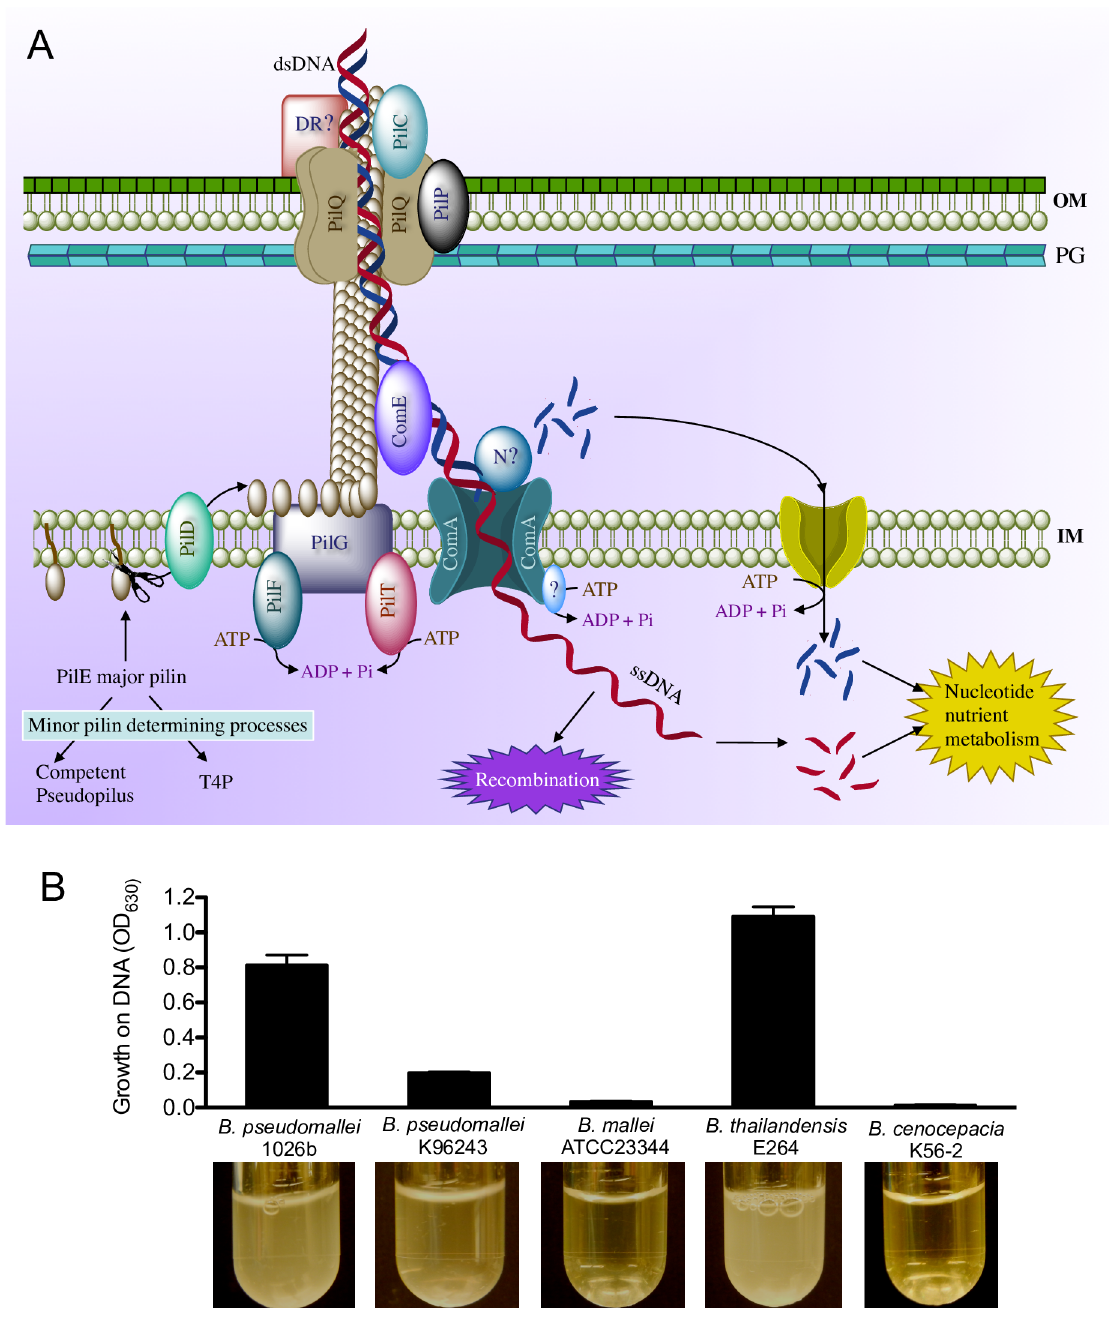
Fig 1. DNA uptake and utilization. (A) Model of DNA uptake in Gram-negative bacteria (see text for detail). (B) Utilizationof DNA as a sole carbon and energysource in selected Burkholderia species. Bp 1026band B . thiailandensis E264 strains exhibitedheavy growth; Bp K96243showedintermediate growth, while Bc K56-2 and B . mallei ATCC23344 were unableto grow on DNA.